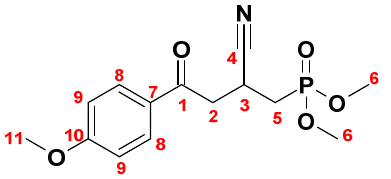
Figure 10. The structure of compound 5j .